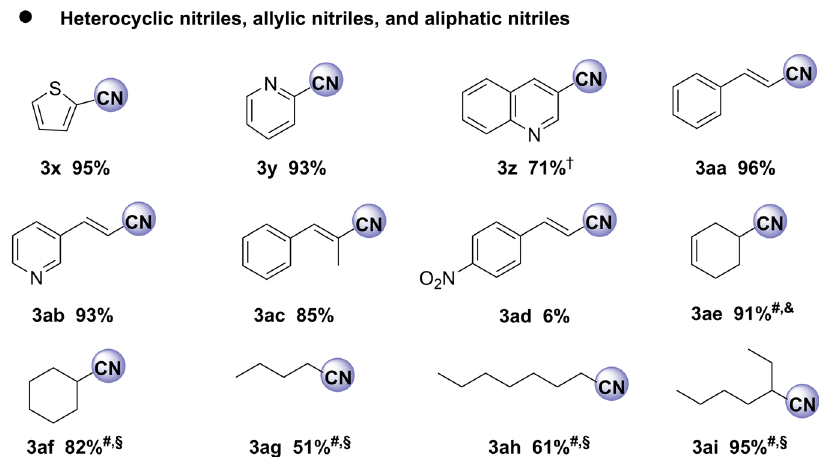
Fig. 6 Synthesis of heterocyclic, allylic, and aliphatic nitriles. Reaction conditions: 0.2 mmol alcohol, 20 mg catalyst (3.9 mol% Fe), aq. NH 3 ·H 2 O (150 mg), 35 °C, 0.1 MPa air, 1.5 mL H 2 O, isolated yields; # Yields were determined by GC using n-hexadecane as internal standard; † 60 °C; § 130 °C, 2 MPa air; & 140 °C, 3 MPa air.